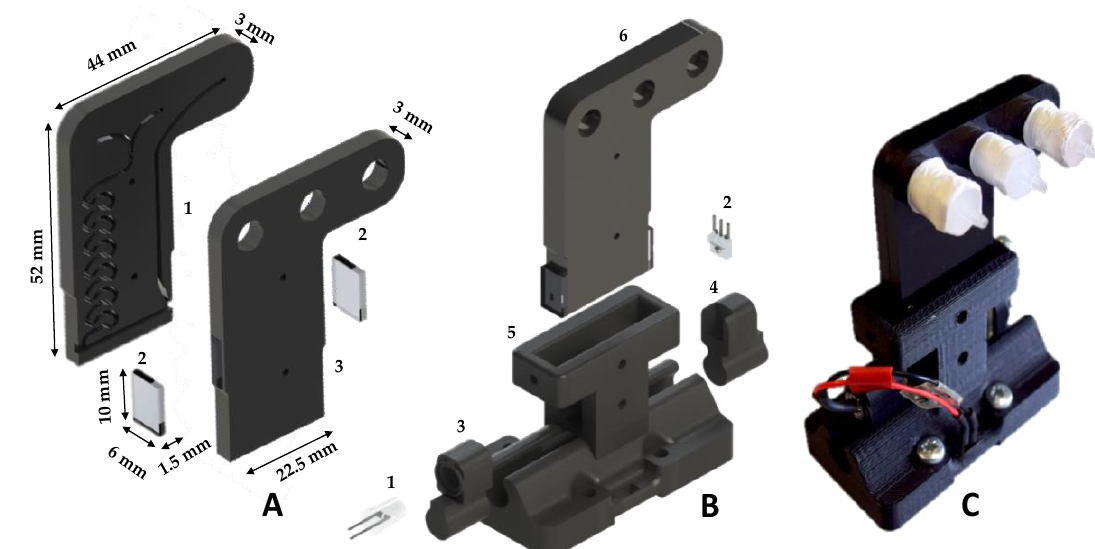
Figure 3. ( A ) Exploded render of the microfluidic chip showing (1) the clear PMMA optical windows at each side of the optical channel; and (2) the top PMMA layer with the milled reagent/sample inlet and waste outlet. ( B ) Render of the microfluidic chip custom 3D printed alignment rail and sliders with detector components: (1) 375 nm UV LED; (2) photodiode; (3) LED slider; (4) photodiode slider; (5) microfluidic chip mount and alignment rail; and (6) microfluidic chip. ( C ) Image of the fluidic chip integrated into the alignment rail.